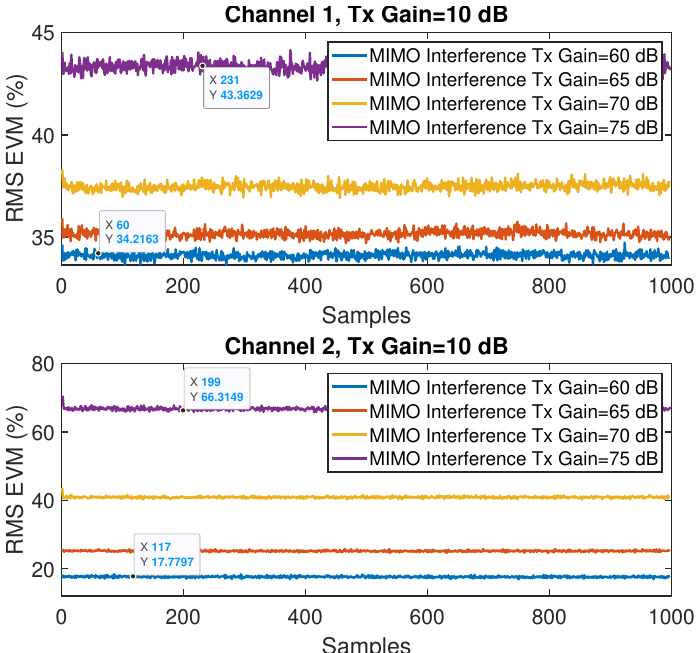
Figure 7. Measured EVM of channel 1 and channel 2 in the presence of different levels of MIMO interference. Tx gain of the USRP is 10 dB.